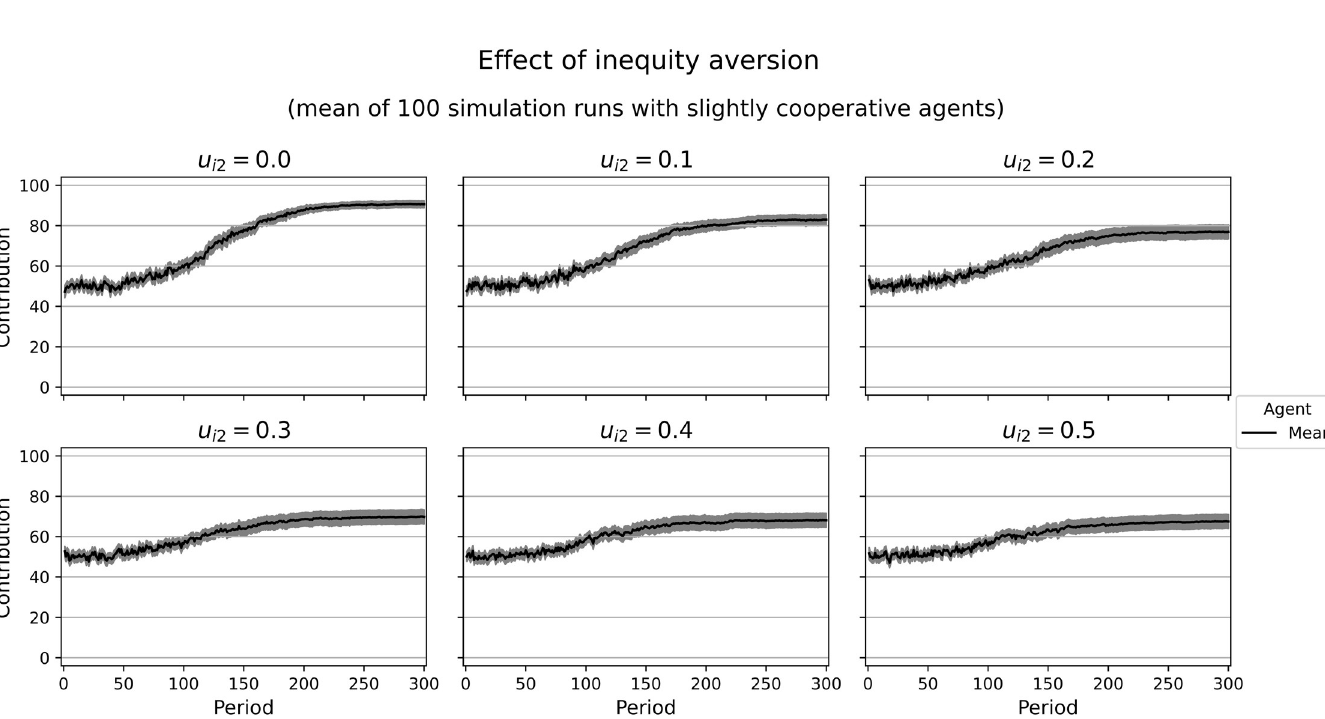
PLOS ONE | https://doi.org/10.1371/journal.pone.0282112 March 15, 2023 17 /